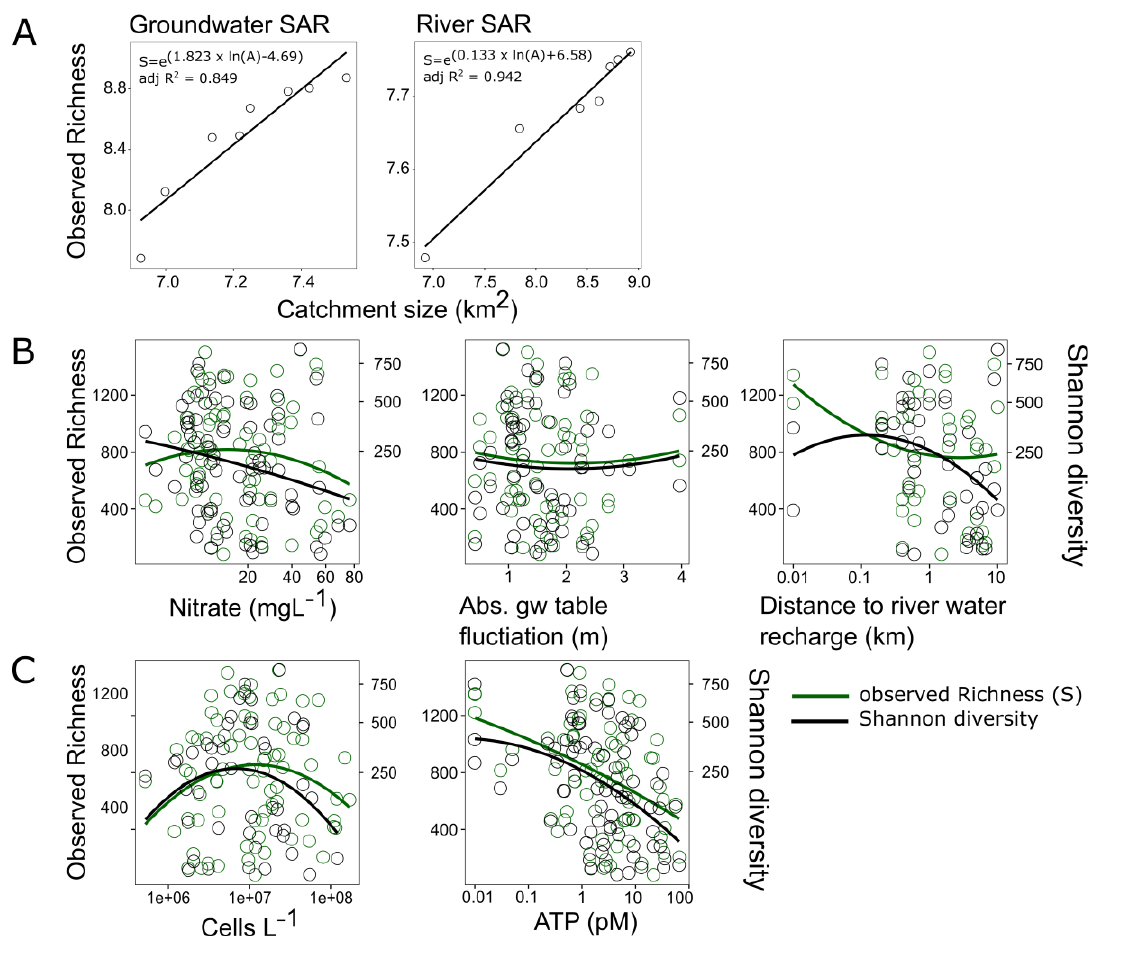
Figure 6. Bivariate SAR linearized log – log power function plot of cumulatively added groundwater and Mur River ASVs (RNA fraction) with increasing catchment area. Groundwater catchment area and observed richness were cumulatively summarized from the groundwater regions closest to the source of the River Mur (LG) to the groundwater regions furthest away (LMV), only adding taxa that were not found in the previous groundwater region. The Mur River catchment sections (from top to bottom: MUR SBG, MUR I, MUR II, MUR III, MUR VI, Laßnitz, MUR V) were also summarized from the source of the Mur River in the Hohe Tauern to the area furthest downstream (MUR V) ( A ). Intermediate disturbance hypothesis ( B ) and productivity – diversity concept ( C ): Biplot of square root-transformed Shannon diversity (black), and observed richness (S; green), as well as square root transformed nitrate (mg L − 1 ), log10 transformed Mur inflow distance (km), and untransformed groundwater level fluctuation between absolute max and min since the year 2000 (m), fitting a 2nd-degree quadratic regression line of the groundwater data, as well as log10 transformed prokaryotic cell counts (cells L − 1 ) and cellular ATP (pM) to meet criteria of a normal distribution.